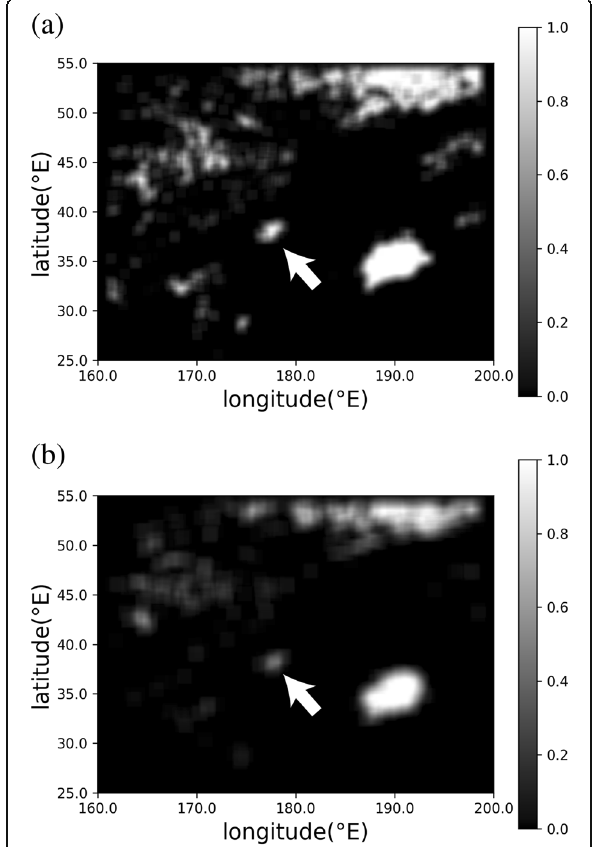
Fig. 4 Probability images for dust in the cases of a N = 20 and b